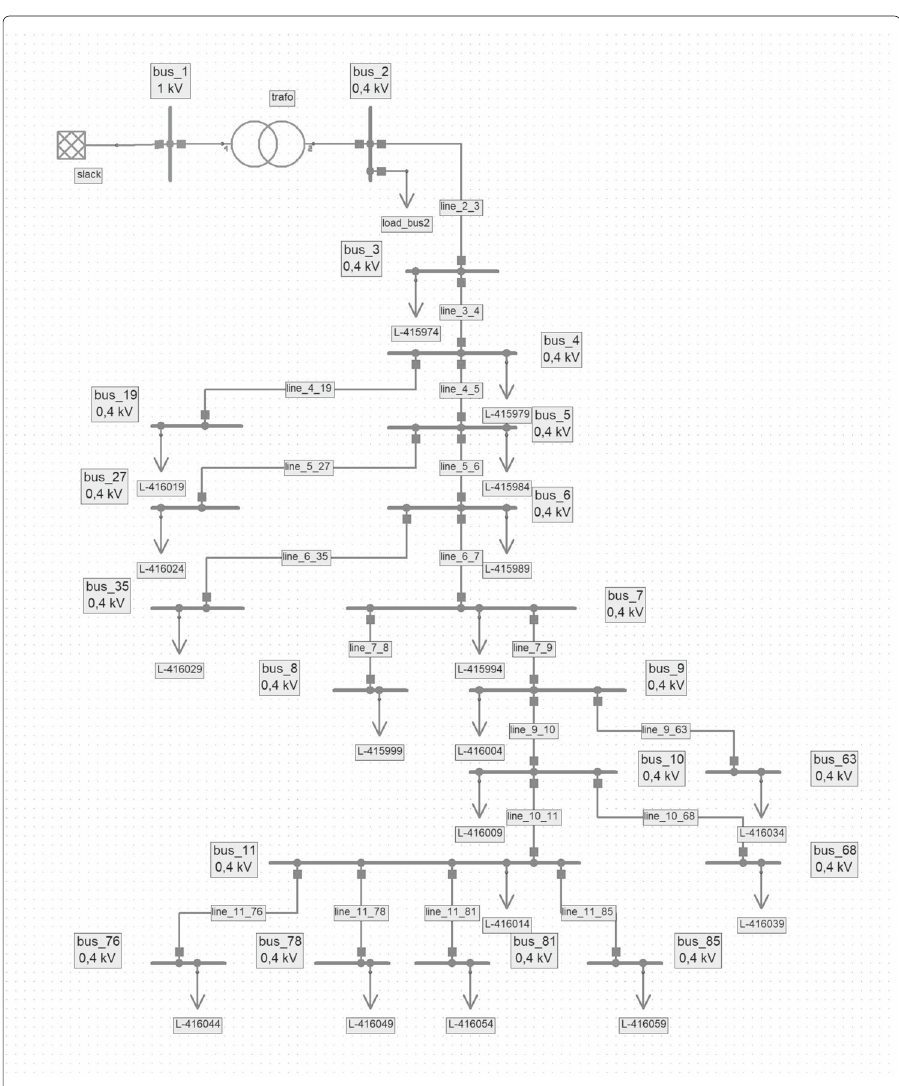
Fig. 2 Simulated 9-Bus System